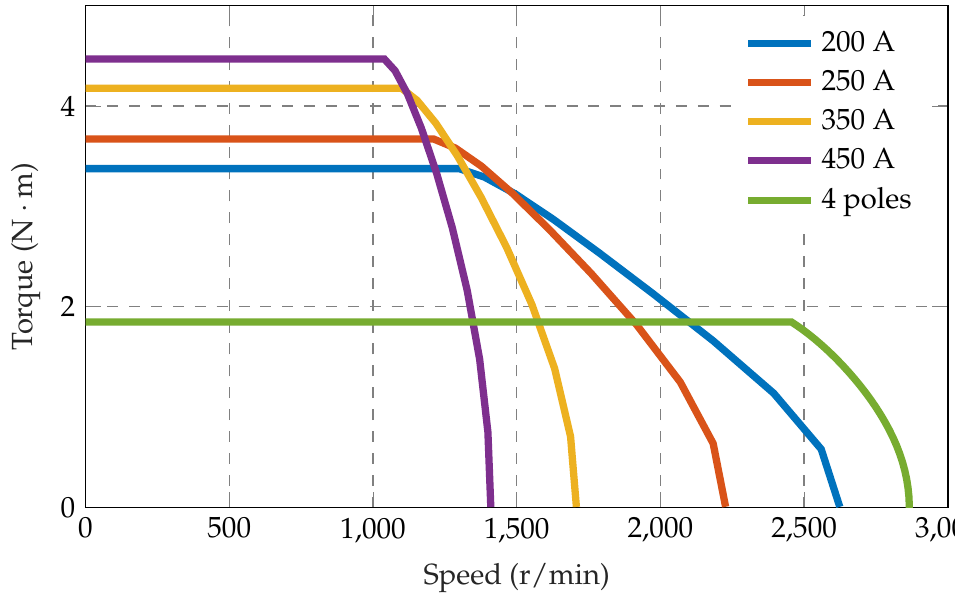
Figure 25. Flux-weakening operation with different excitation Figure 25. Flux weakening operation with different excitation currents.